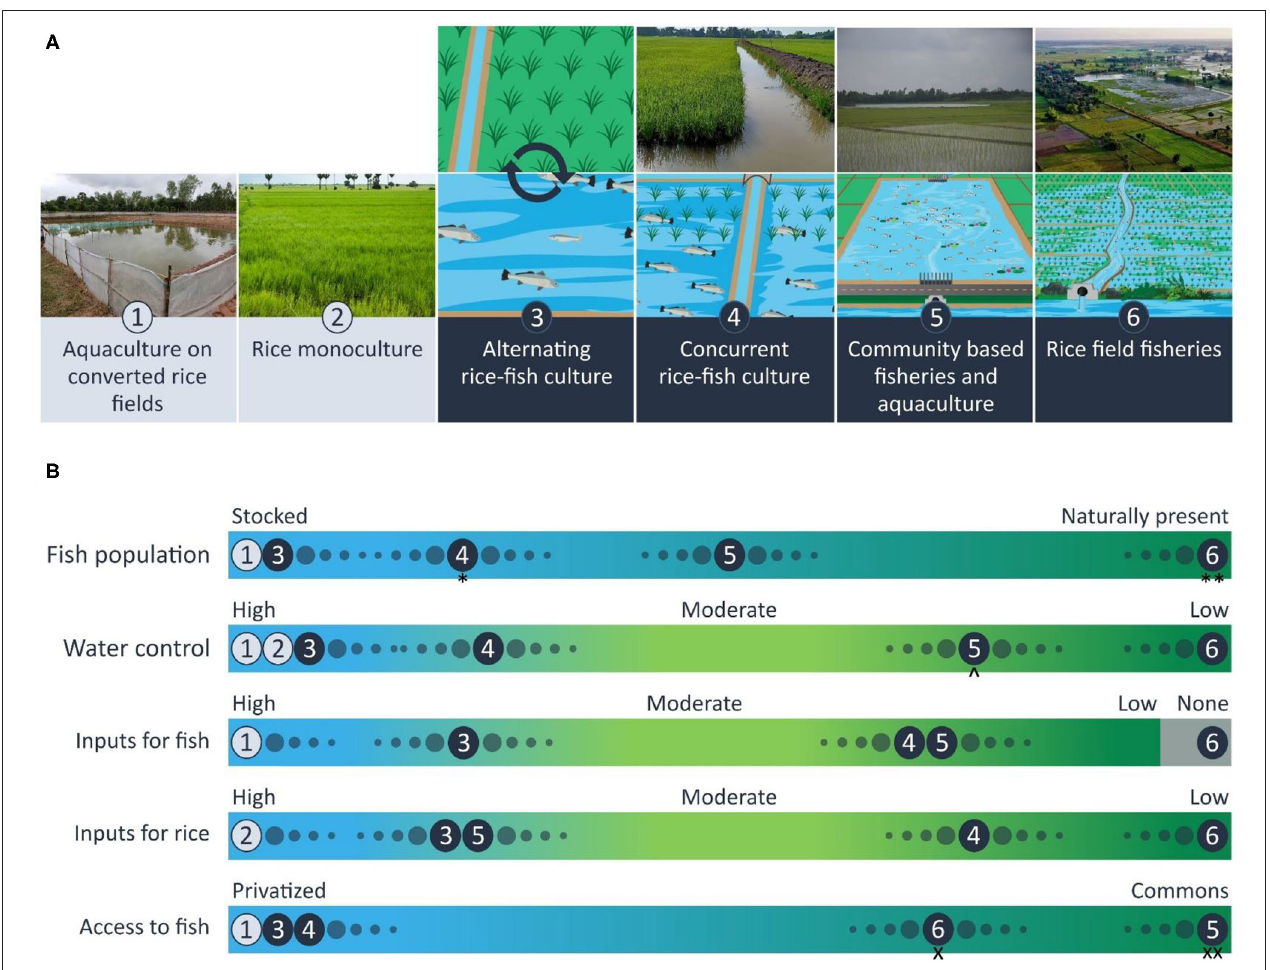
FIGURE 1 | Typology of rice-fish production practices with (A) illustrations and photos that depict each of four exemplars (3–6) and their monoculture reference points (1,2). (B) The types can be distinguished by use of agroecological attributes along a continuum of (high to low) control and substitution of natural processes in terms of; (1) fish stocks, (2) water control, (3) inputs to support fish production, (4) inputs for rice, and (5) institutions that control access to fish. Notes: *May include some naturally present; **May include some stocking; ∧ Water control is low during monsoon season and fish production, but irrigation is used during dry season for rice cultivation; × May include privatization of fish remaining in ponds within rice fields after flood recession; ×× Commons for small wild fish harvest, contractual shared access for cultured and wild